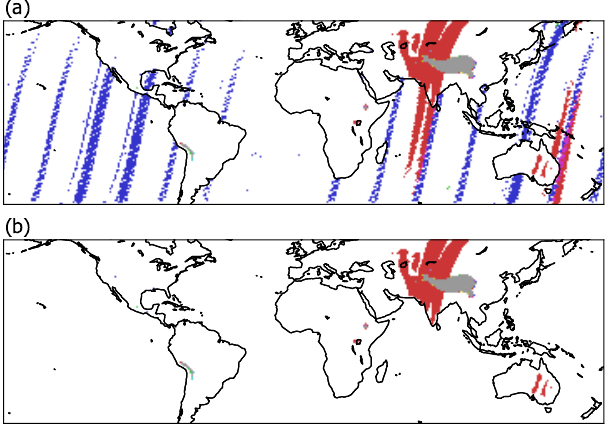
Figure C1. Warning flags for V (a) and V (cid:48) (b) . Warnings for GOME, SCIAMACHY, and GOME-2 are color coded as RGB; i.e., red indicates a warning for GOME only, while magenta indicates a warning for both GOME (R) and GOME-2 (B). Gray (e.g., over the Himalayas) indicates a warning for all instruments and is caused by persistent gaps due to the simple O 2 cloud